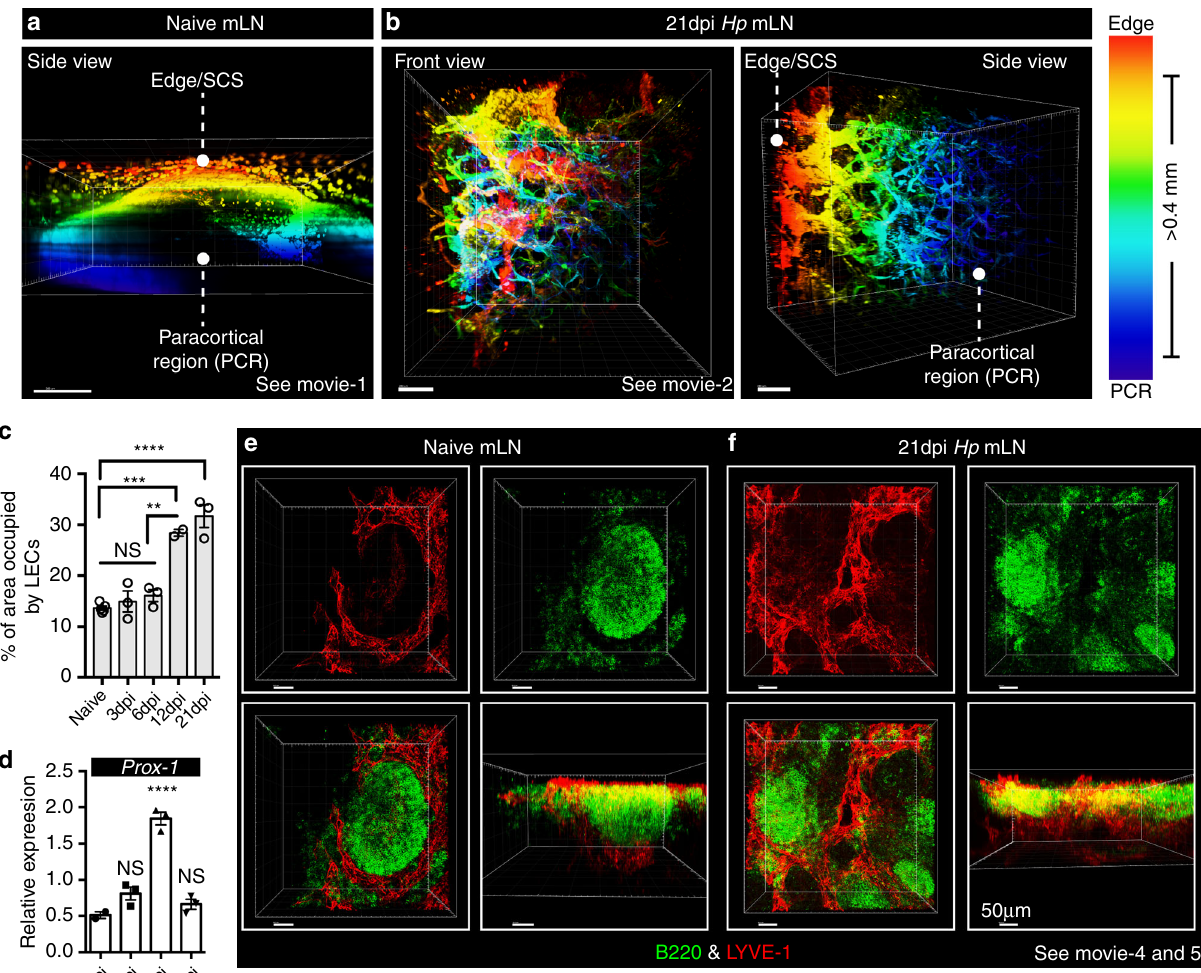
Fig. 1 Intestinal helminth infection triggers mLN lymphangiogenesis. C57BL/6J mice were infected with Hp and the entire chain of the mLN collected at the indicated time-points. a , b LYVE-1 + lymphatic networks in the mLN of naive and 21 dpi infected mice were visualized by deep tissue imaging. Temporal color pro fi les are used to indicate the LYVE-1 + lymphatic network in relation to cortical and paracortical regions. SCS; subcapsular sinus ( red ), PCR paracortical region ( blue ). c Quantitation of the mLN area occupied by lymphatics (LYVE-1 + LECs) in C57BL/6 mice following Hp infection. Data are pooled from two independent experiments and represent mean ± SEM. Each dot represents an individual animal. d Relative expression of mRNA encoding Prox-1 in whole mLN over the indicated time course. Data is from a single experiment and is representative of ≥ 3 independent experiments. e , f Vibratome sections of mLNs showing 2D and 3D views of combined immuno fl uorescence staining for B-cell follicles (B220; green ) and lymphatics (LYVE-1; red ). Scale bar = 50 μ m. Images are taken from a single mouse and are representative of three independent experiments. For all data shown, each independent experiment included n ≥ 2 – 3 mice/group/time-point. See also Supplementary Movies 1 – 2 and Supplementary movies 4 –